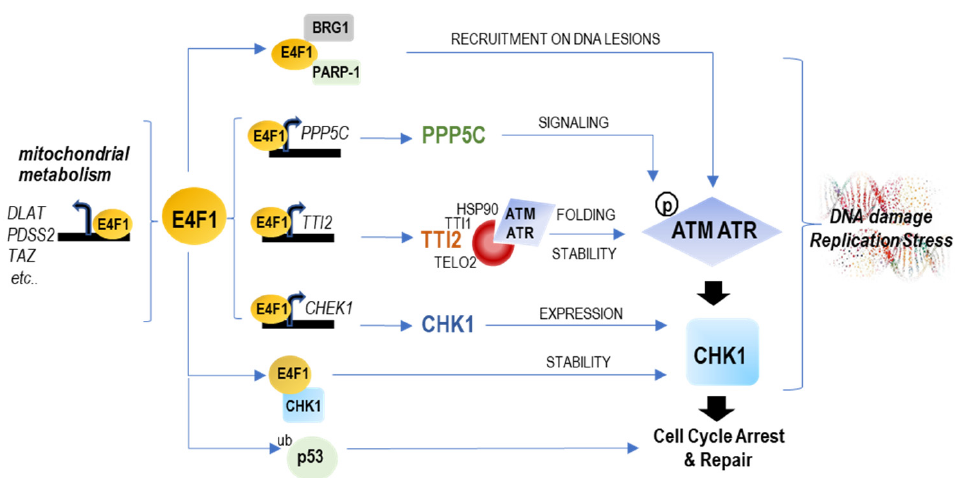
Figure 7. Schematic representation of the different levels of controls exercised by E4F1 on mitochon- drial metabolism and the ATM/ATR–CHK1 axis. E4F1 is an ubiquitously expressed transcription factor that binds a limited set of genes (around 100), including its own promoter, as reported in mouse [17,18] and here in human cells. On the one hand, E4F1 controls genes important for mito- chondrial homeostasis and metabolic functions, including a set of genes involved in pyruvate oxi- dation [19,20], that we termed a “PDH regulon” and which include DLAT, DLD, MPC1 and slc25A1 ). On the other hand, E4F1 directly binds and controls the expression of the CHEK1 gene, as observed in mouse cells [17] and here in human TNBC cells. Here, we also found that E4F1 directly binds and regulates two other genes, TTI2 and PPP5C, encoding upstream post-translational regulators of the ATM/ATR-CHK1 signaling pathway. TTI2 is a component of the molecular co-chaperone TTT complex which specifically recognizes the newly synthesized ATM and ATR kinases, and is essential for their correct folding and stability [39,41]. PPP5C is a protein phosphatase that activates ATM, ATR and CHK1 kinase activities [36–38]. Other recent reports show that the E4F1 protein also directly interacts with the CHK1 Kinase to modulate CHK1 protein stability and activity [10], and also cooperates with PARP-1 and BRG1 to trigger ATM/ATR signaling at DNA lesions [11]. Altogether, this suggests the existence of a hitherto unidentified “ATM/ATR-CHK1 regulon” controlled by E4F1.